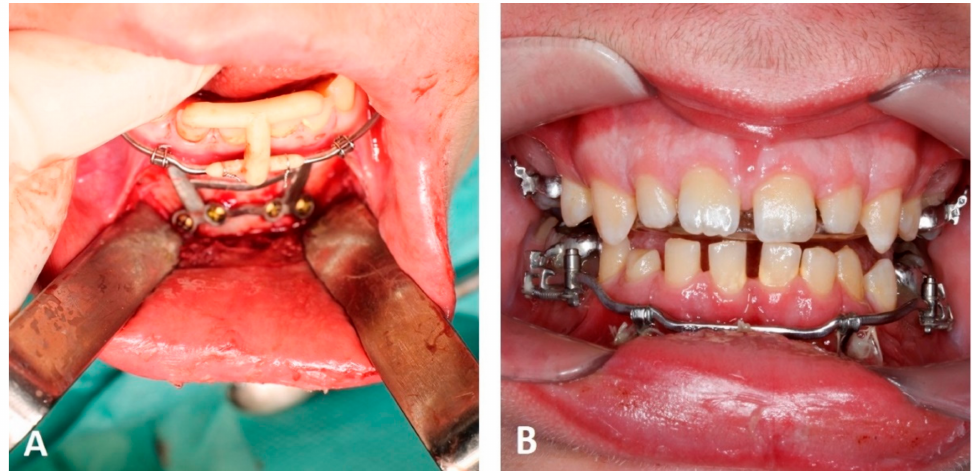
Figure 10. Clinical installation of a CAD/CAM manufactured Mentoplate with mesial-slider supra- construction. ( A ) Surgical insertion and anterior vertical control with guide. ( B ) Intraoral situation with installed